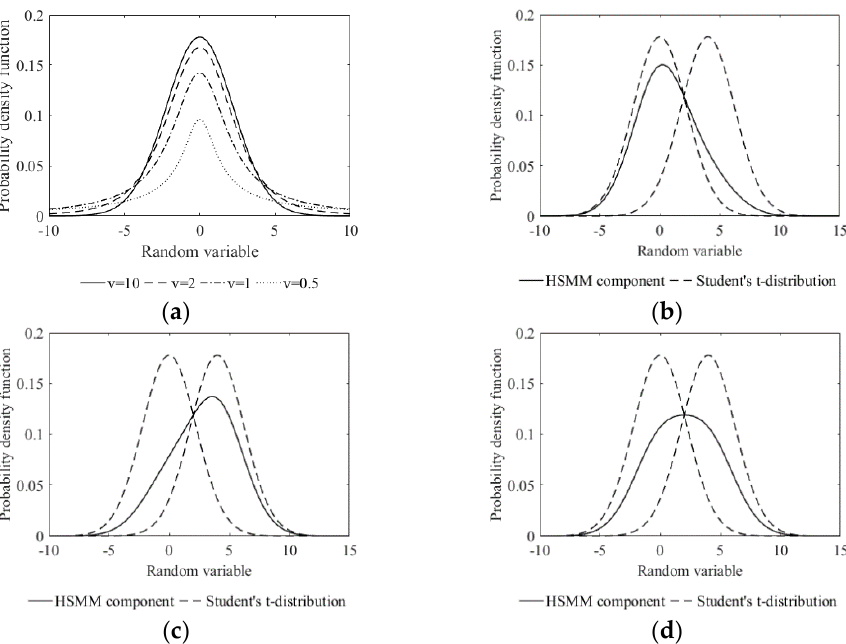
Figure 2. The components of SMM and HSMM. ( a ) The components of SMM under varying degrees of freedom ( v is set to 10, 2, 1, and 0.5). ( b ) The HGMM components with weights (0.8, 0.2). ( c ) The HGMM components with weights (0.3, 0.7). ( d ) The HGMM components with weights (0.5, 0.5).